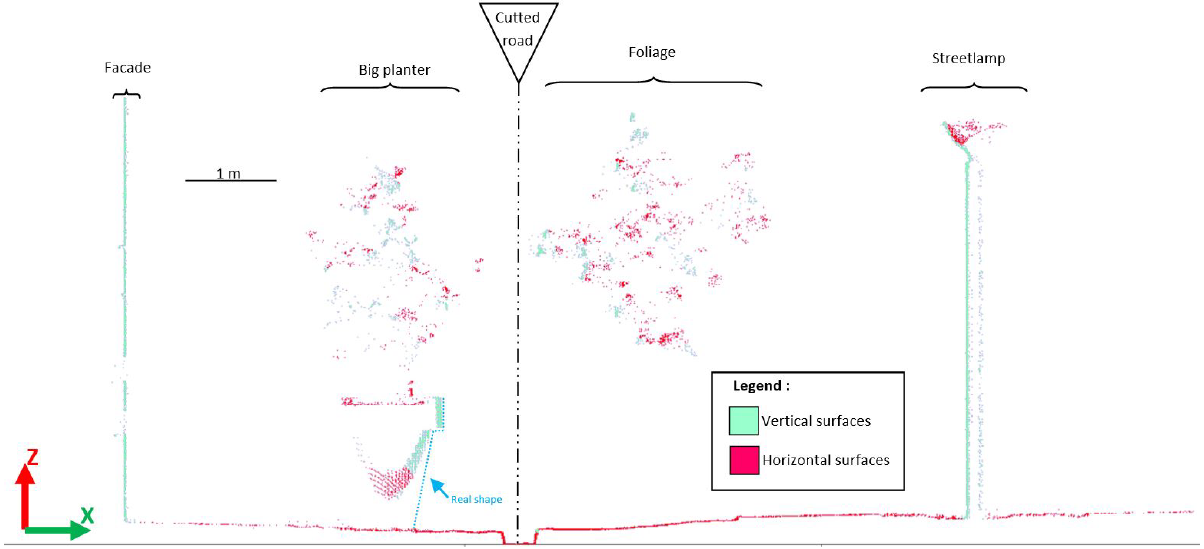
Figure 3: Classification of the points belonging to a cross-section into vertical (green) and horizontal (red)